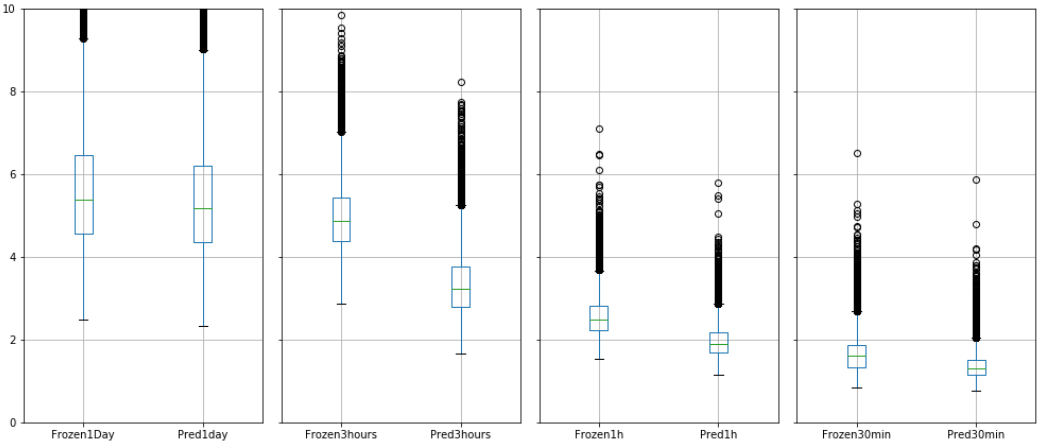
Figure 11. Box plot of the TEC RMSE, for the case of forecast with frozen value ( left ) and the tangent space ( right ), for each horizon (see the tick labels of each